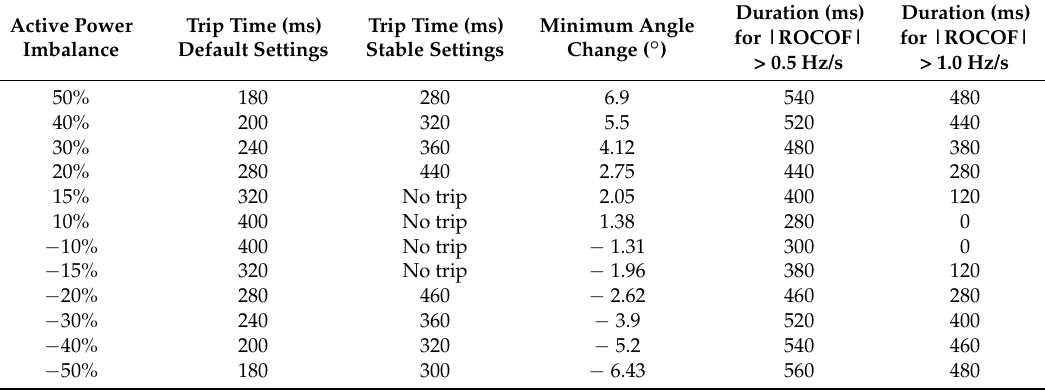
Table 3. Sensitivity test with the default settings and stable settings for composite PAD solution.